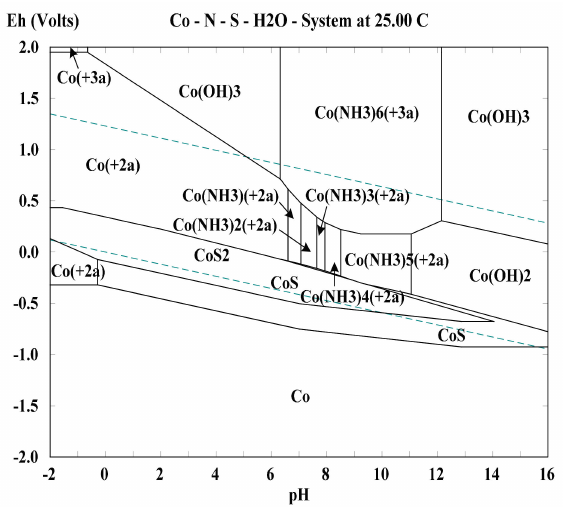
Figure 7. Eh–pH diagram of Co–NH 3 –S 2 O 32 − –H 2 O system under the conditions of 0.05 M Co, 1.0